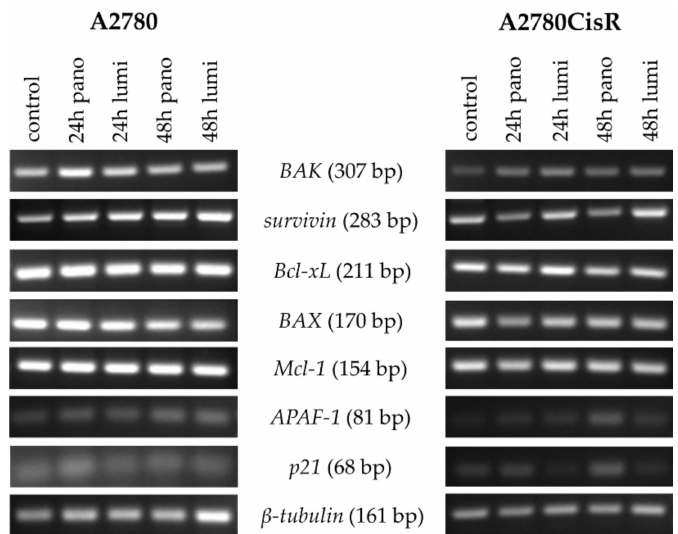
Figure 3. E ff ects of HDACi or HSP90i incubation on apoptosis-related genes. Gene expression data were obtained by PCR. Cells were treated with 10 nM (A2780) or 20 nM (A2780CisR) panobinostat or 5 nM (A2780) or 10 nM (A2780CisR) luminespib for 24 or 48